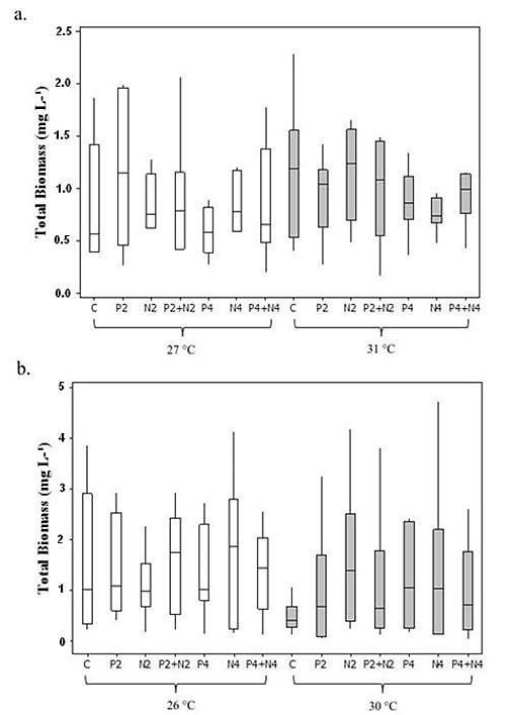
Figure 2. Variation (medians and quartiles, n = 8) of the species richness (n˚ spp.) in different nutritional enrichment and temperature treatments, for the rainy season (a) and dry season (b). White bars represent the temperature control treatments and the ashes the warming temperature